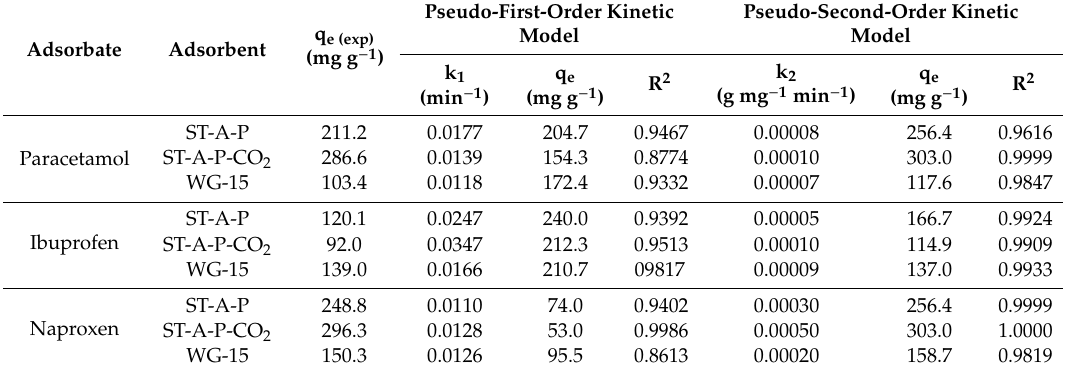
Table 5. Kinetic parameters of paracetamol and NSAIDs adsorption on the studied adsorbents.